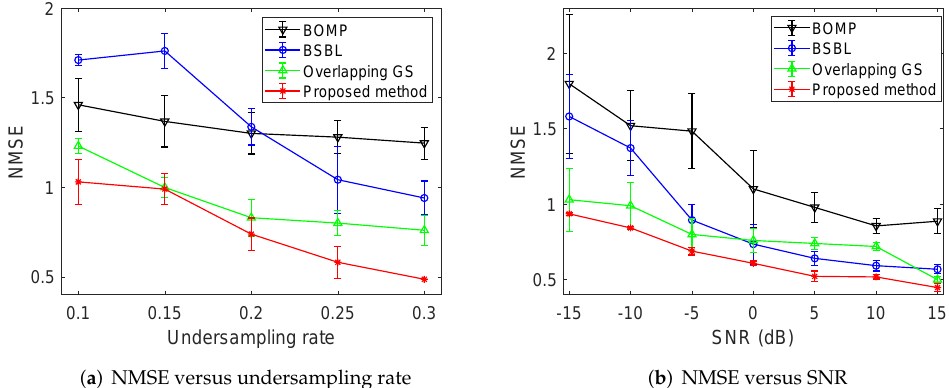
Figure 4. Comparison of reconstructed performance corresponding to different undersampling Rate and